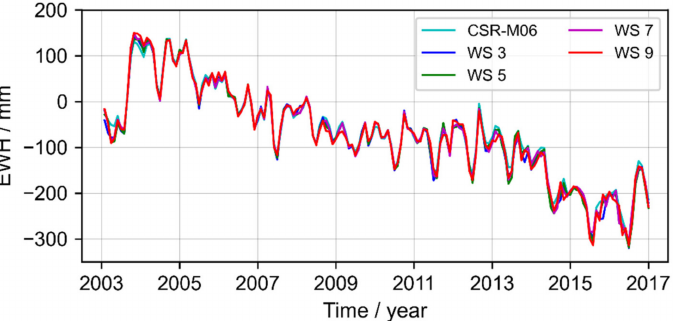
Figure 7. The time series of the downscaled results and CSR-M06 in Guantao County.